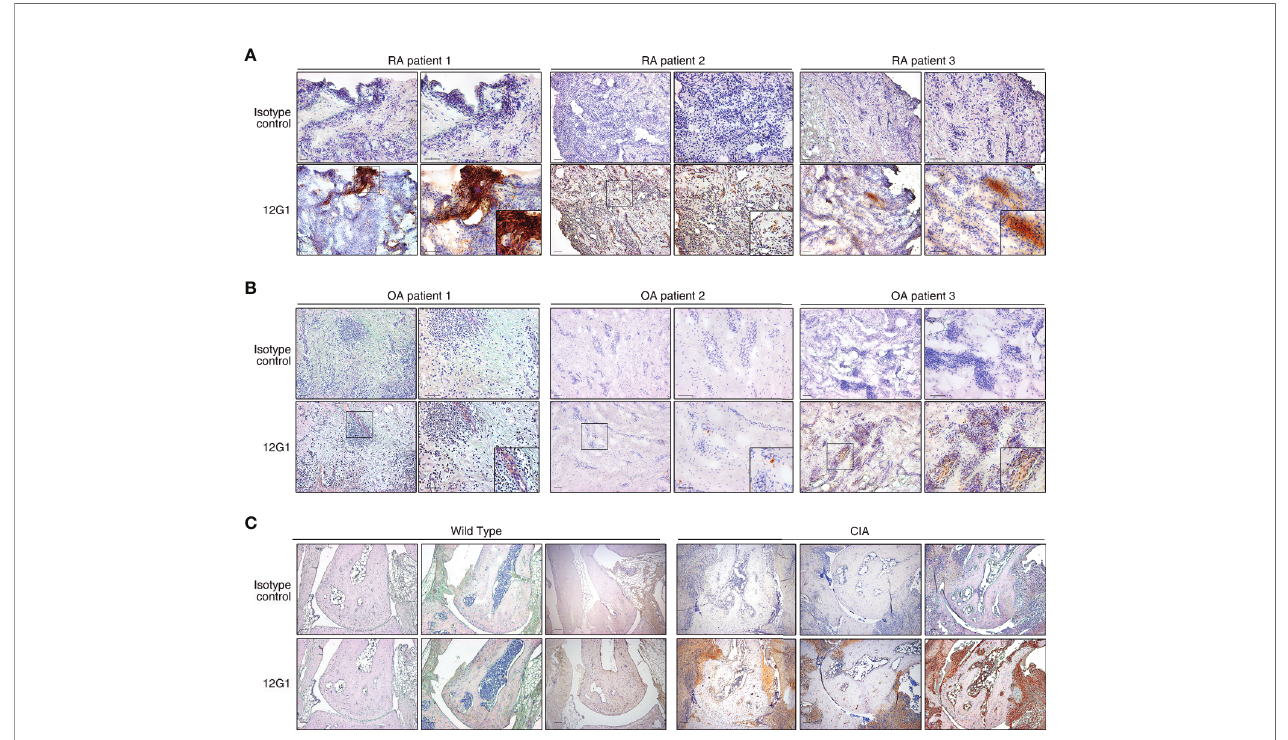
FIGURE 2 | The 12G1 mAb is speci fi c for citrullinated proteins in RA synovial tissue. Representative images showing immunohistochemical (IHC) staining of citrullinated proteins in RA and OA. (A) The IHC analysis was performed using the 12G1 mAb in joint synovium tissue specimens from three RA patients (RA patients 1-3). To ascertain whether any antigens could be detected by the 12G1 mAb in nonin fl ammatory synovial tissues, synovial tissues from three OA patients (B) were stained with 12G1 mAb at the same time. An isotype control antibody was used as a negative control. (C) A joint with collagen-induced arthritis (CIA) was stained with the 12G1 mAb. The black box shows the stained synovial tissue at a higher magni fi cation. The magni fi cation is indicated for each image in this fi gure. All scale bars represent 100